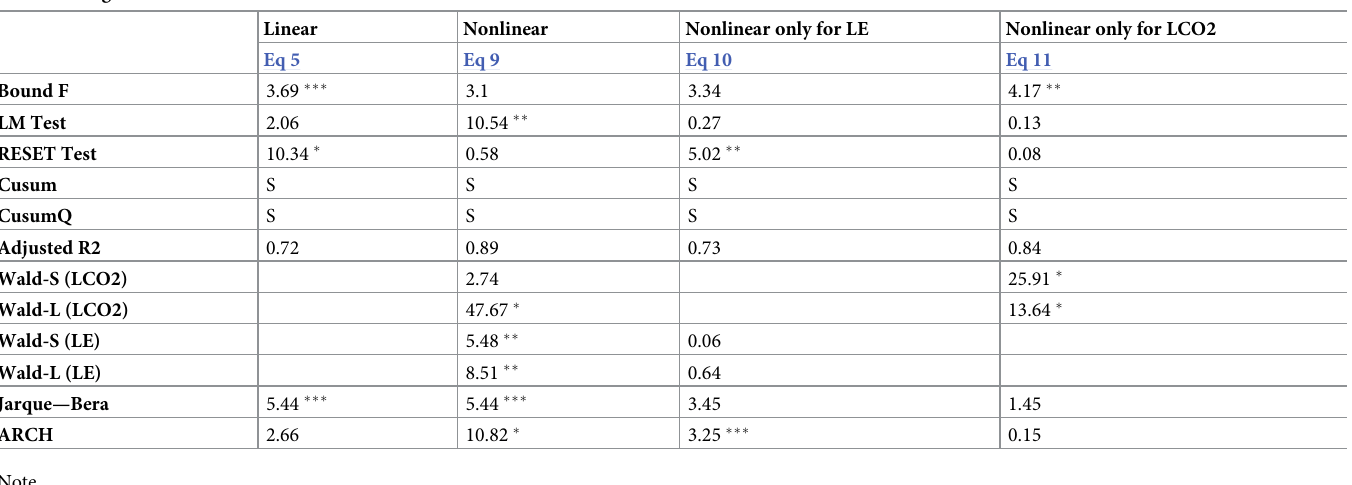
Table 5. Diagnostic statistics associated with linear and nonlinear ARDL